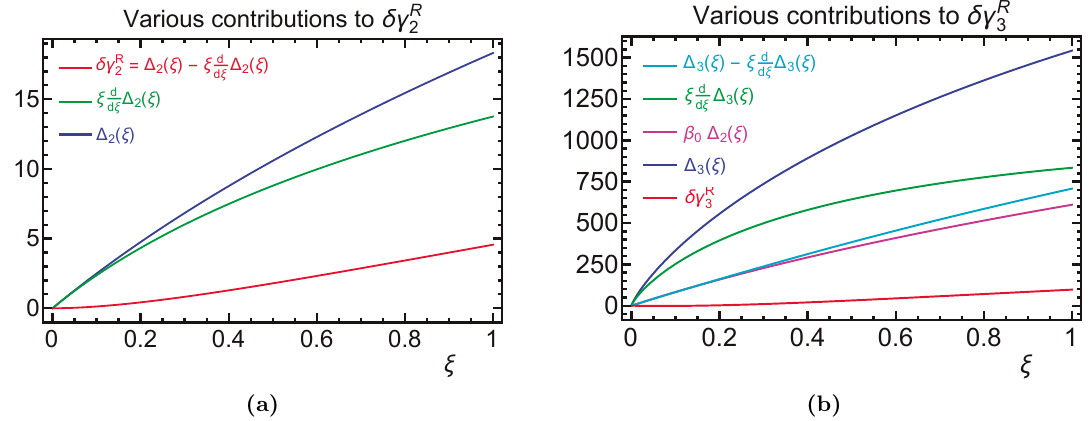
Figure 2. Finite lighter quark mass corrections to the R-anomalous dimension at two and three loops. The various pieces in which (cid:14)(cid:13) R (left panel) and (cid:14)(cid:13) R (right panel) are decomposed are shown 2 3 separately. These pieces correspond to the terms shown in eq.